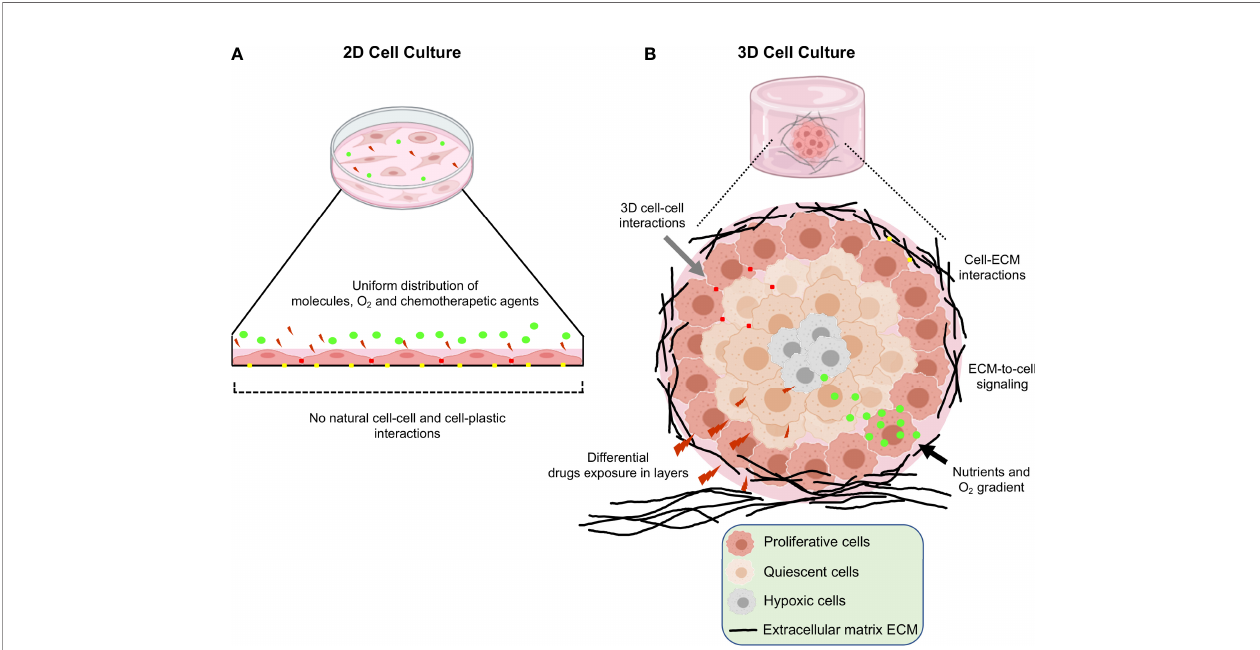
FIGURE 1 | Schematic representation of the main differences between 2D and 3D cell cultures. (A) Traditional 2D cell culture in which fl attened cells grown in a monolayer at the bottom of plastic plates. Reduced cell-cell interactions, unlimited exposure to nutrients, oxygen and drugs are limitations of this type of cultures. (B) 3D cell culture systems; in which increased cell-cell and cell-extracellular matrix interactions, limited access to nutrients, oxygen, and heterogeneity in the drugs interactions leads to better recapitulation of the tumor microenvironment occurring in vivo .